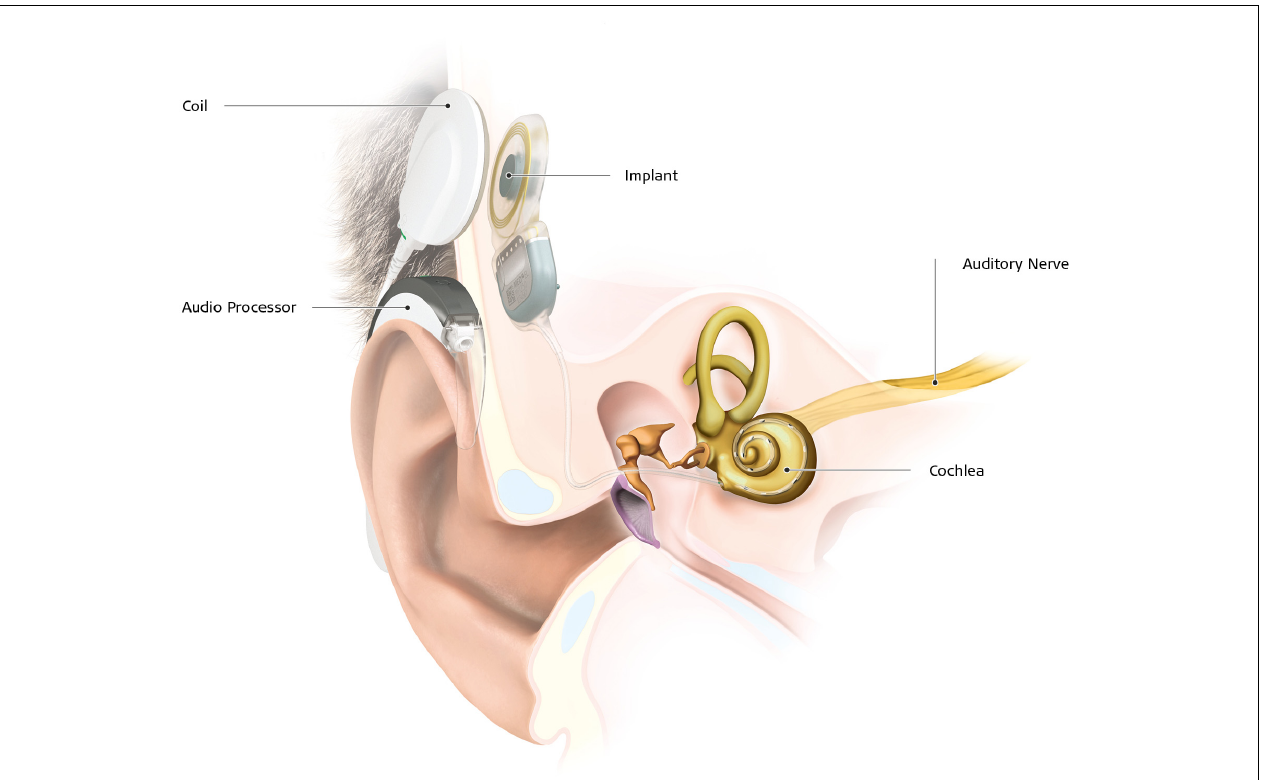
FIGURE 1 | Cochlear implant with its two main components. The external part, which is placed behind the ear, is composed of a microphone, an audio processor, a battery and a coil, kept in place in front of the internal part by a magnet. The internal part is placed during a surgical procedure under general anesthesia. The implant transmits the electrical stimulation to the fibers of the cochlear nerve through electrodes placed in the cochlea (from MED-EL©